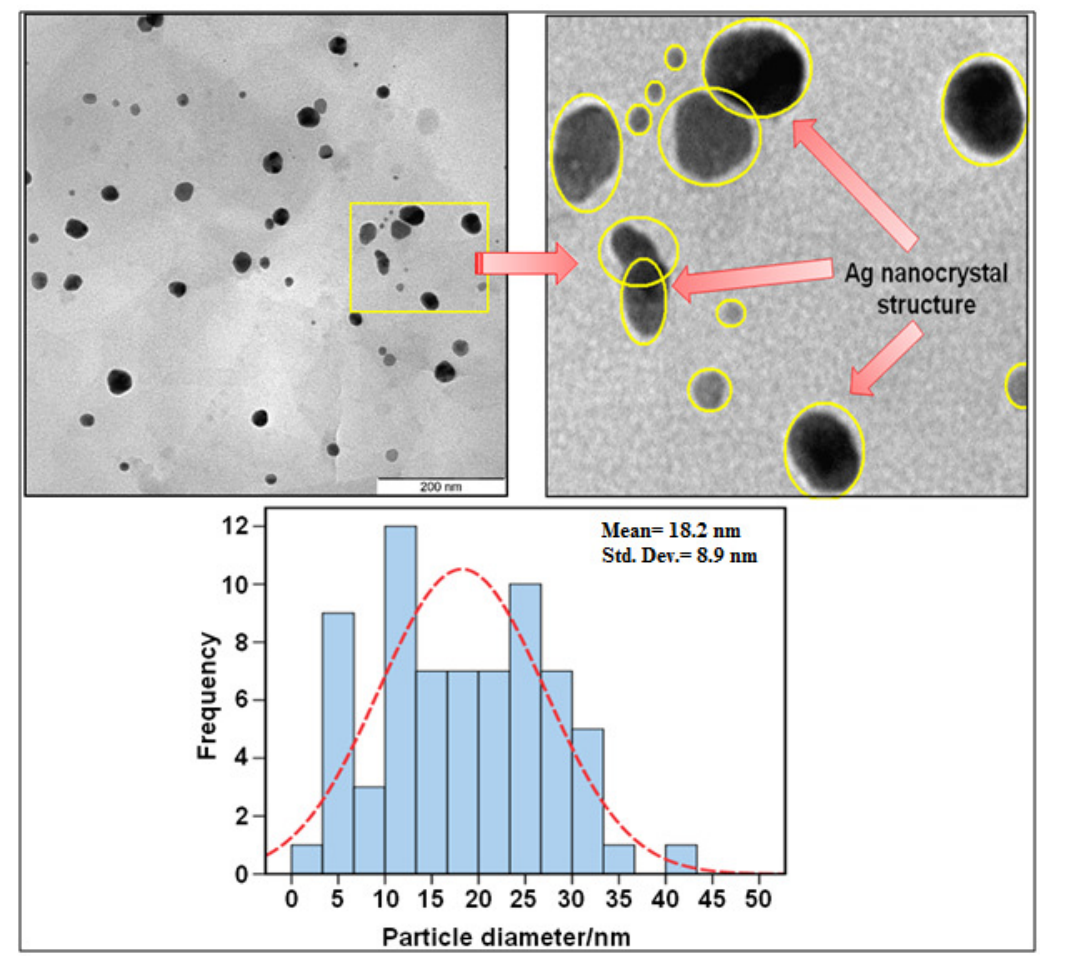
Figure 4. TEM image and corresponding size distribution of Ag/ Vitex negundo after 48